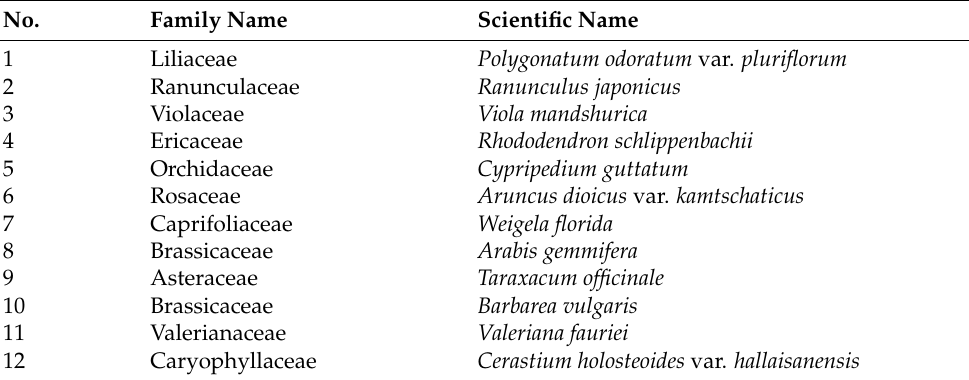
Table 1. List of insect-pollinated plants flowering at the Manhangjae site in the Republic of Korea during the survey period (12 May to 7 June